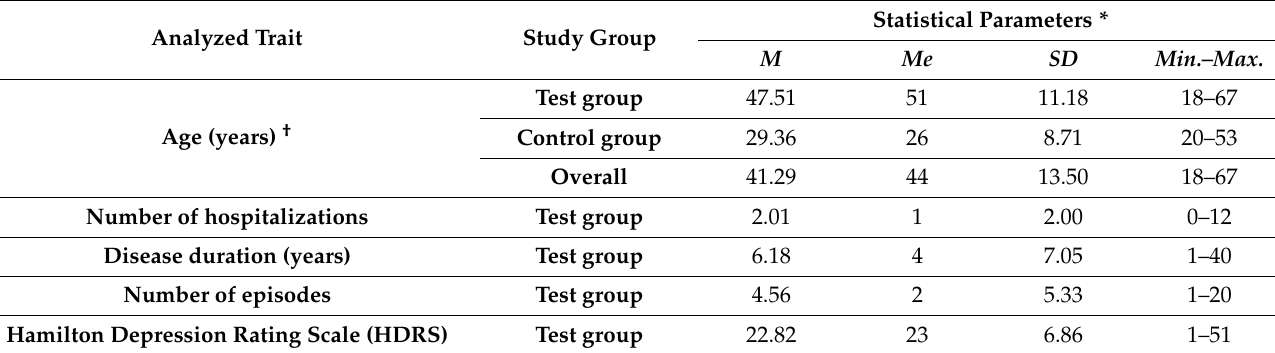
Table 1. Characteristics of the study cohort by nosologic